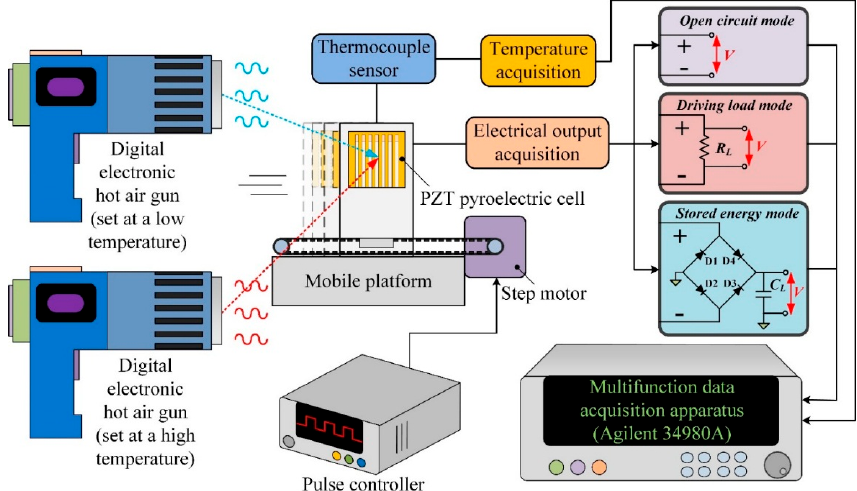
Figure 6. Measurement setup for the PZT pyroelectric harvester.